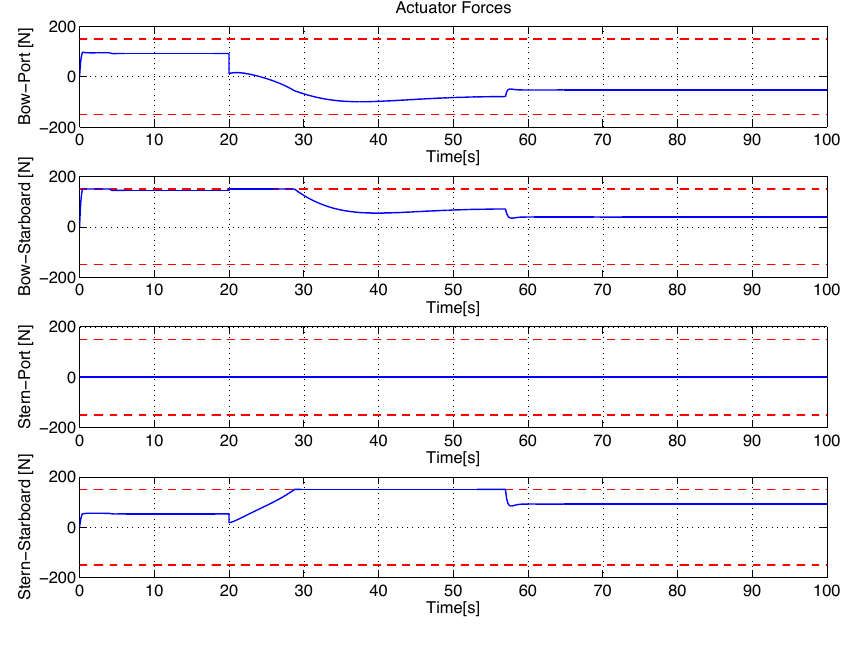
Figure 12: Actuator forces for a vehicle change in position while in current with an actuator fault.